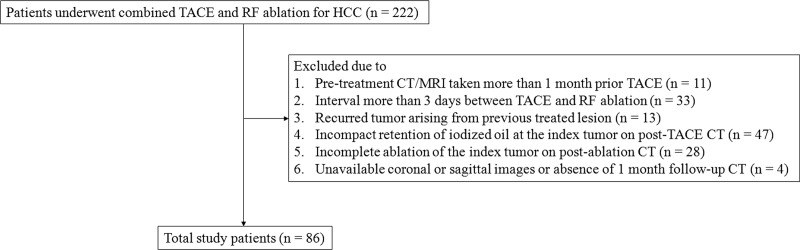
Flow chart of patient selection.TACE = transcatheter arterial chemoembolization, RF = radiofrequency, HCC = hepatocellular carcinoma.